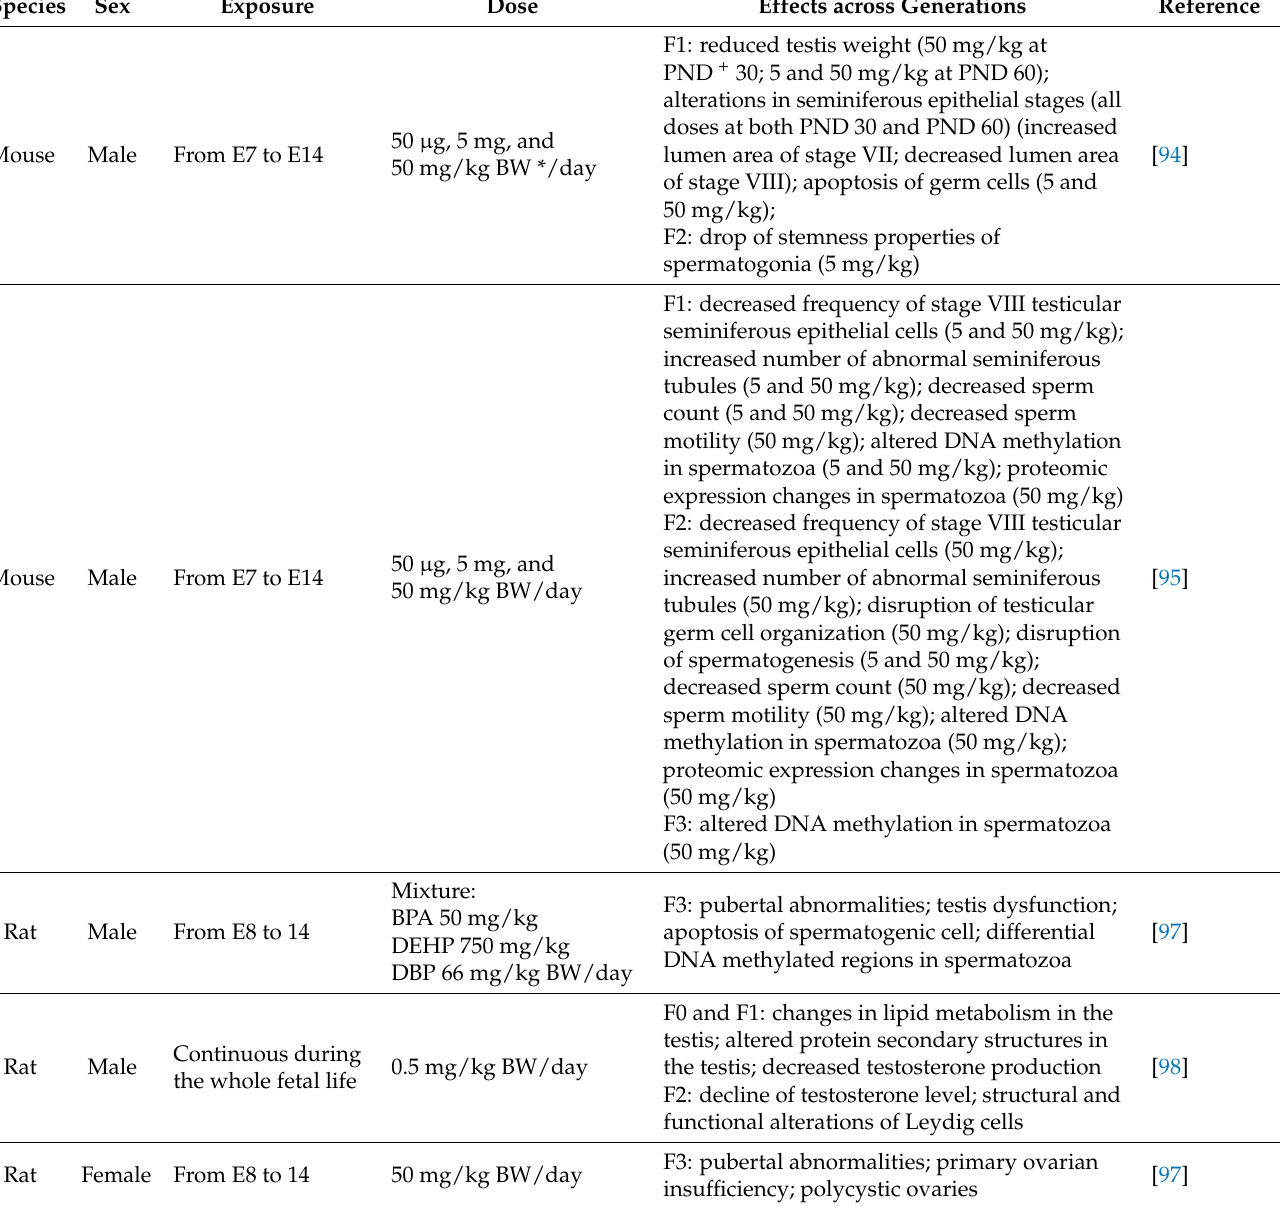
Table 2. BPA-Induced Effects In Model Animals Across